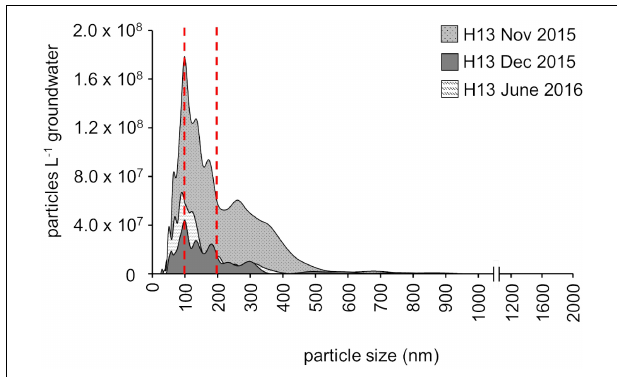
FIGURE 3 | Content and size distribution of groundwater particles from the first well of the transect, H13 (5.1 m below the surface), assessed by nanoparticle tracking analysis (NTA) for three different time points (November 2015, December 2015, January 2016; one replicate per time point). The red lines indicate filter pore size commonly used for microbial biomass collection in environmental surveys (0.2 µ m) and the (0.1 µ m) filter pore size additionally used